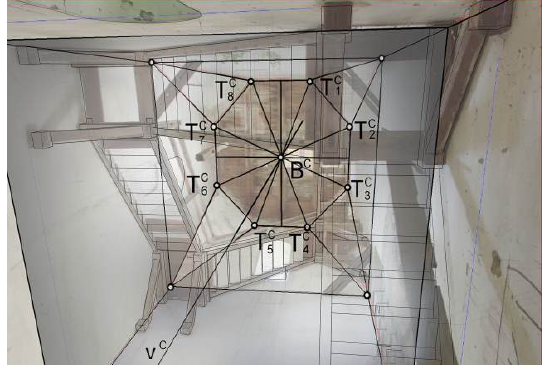
Figure 7. The SVR model of the tower’s interior.